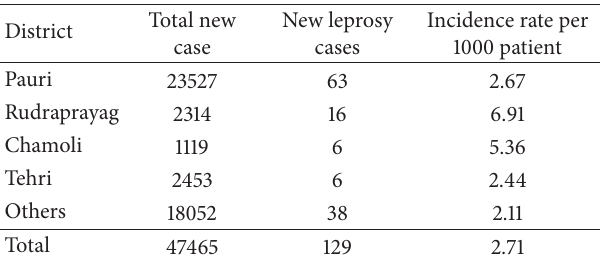
Table 3: Observed incidence rates of leprosy per 1000 patient by district in a tertiary care hospital in Srinagar, Garhwal, North